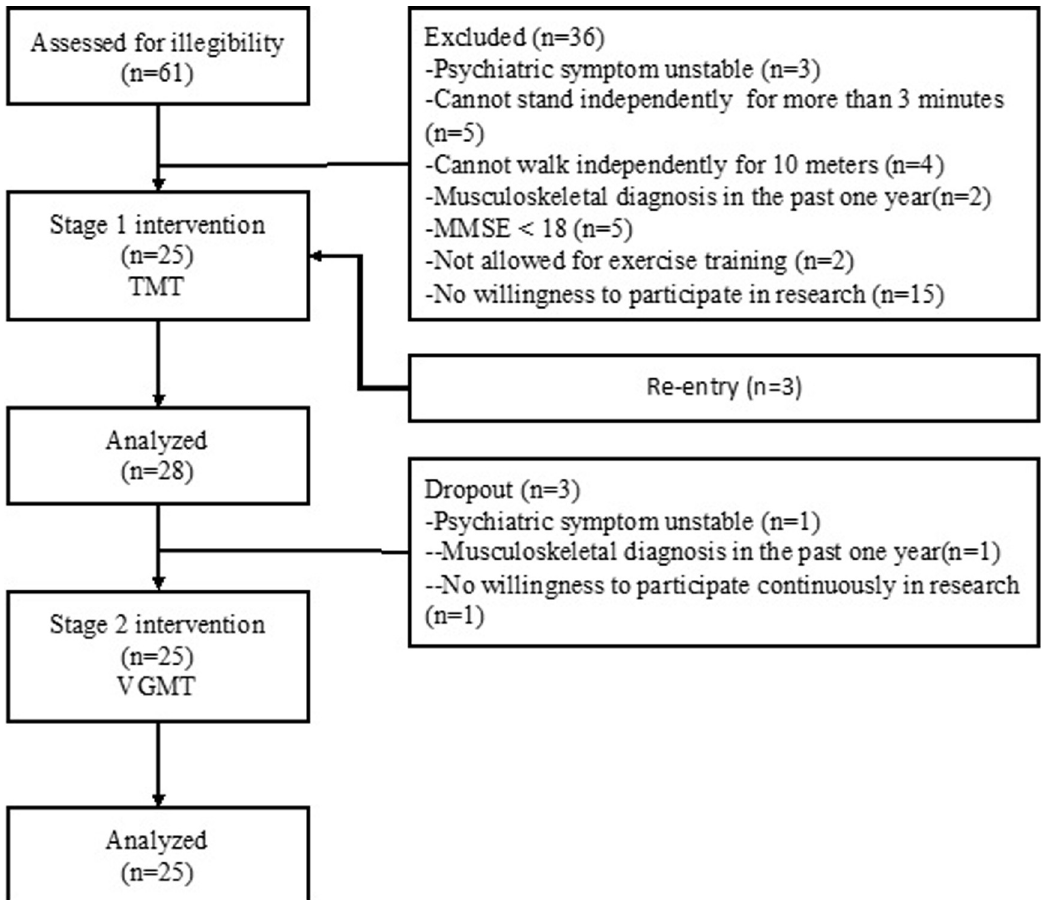
Fig 1. Participants enrollment and allocation